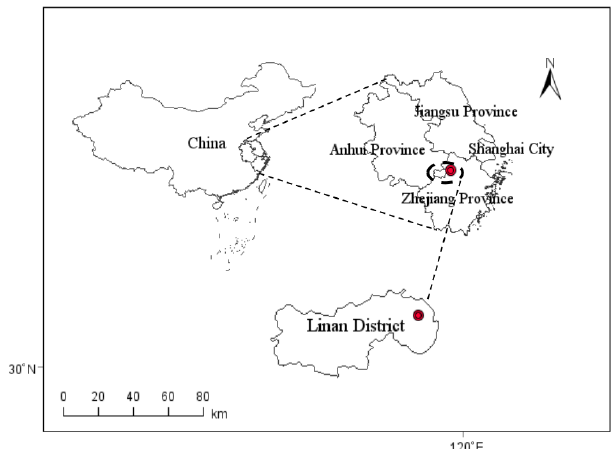
Figure 1. Geographical location of